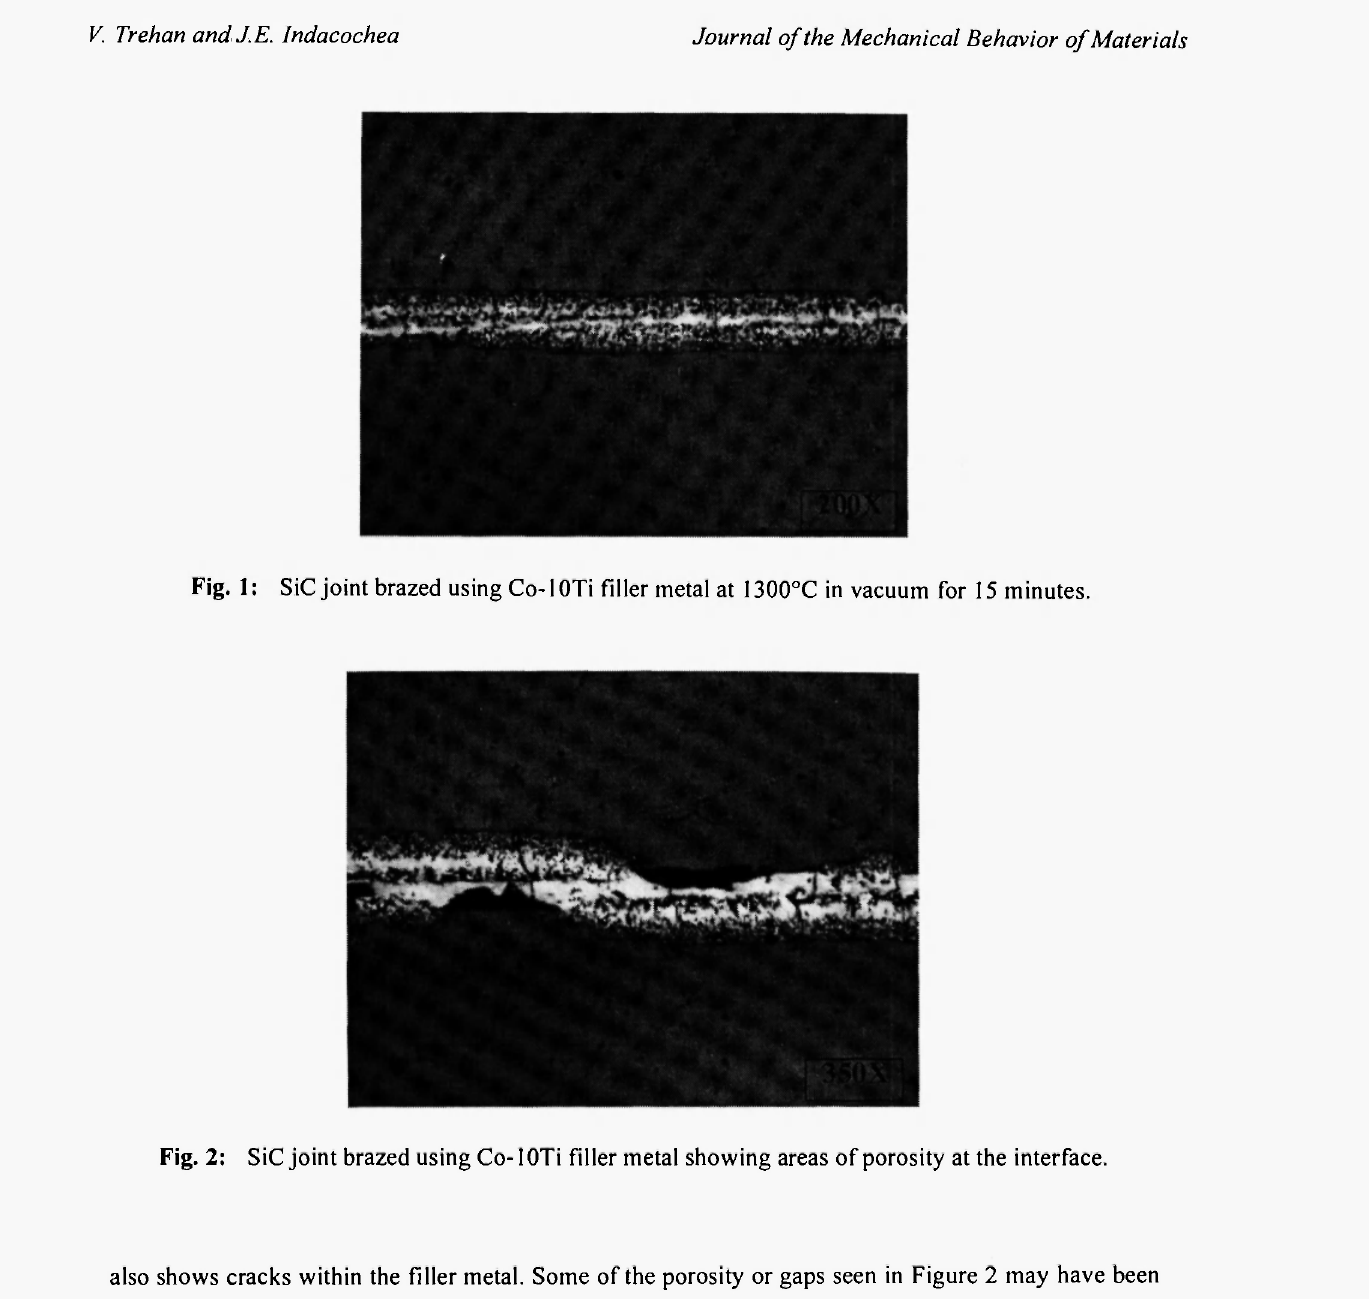
Fig. 2: SiC joint brazed using Co-IOTi filler metal showing areas of porosity at the interface.